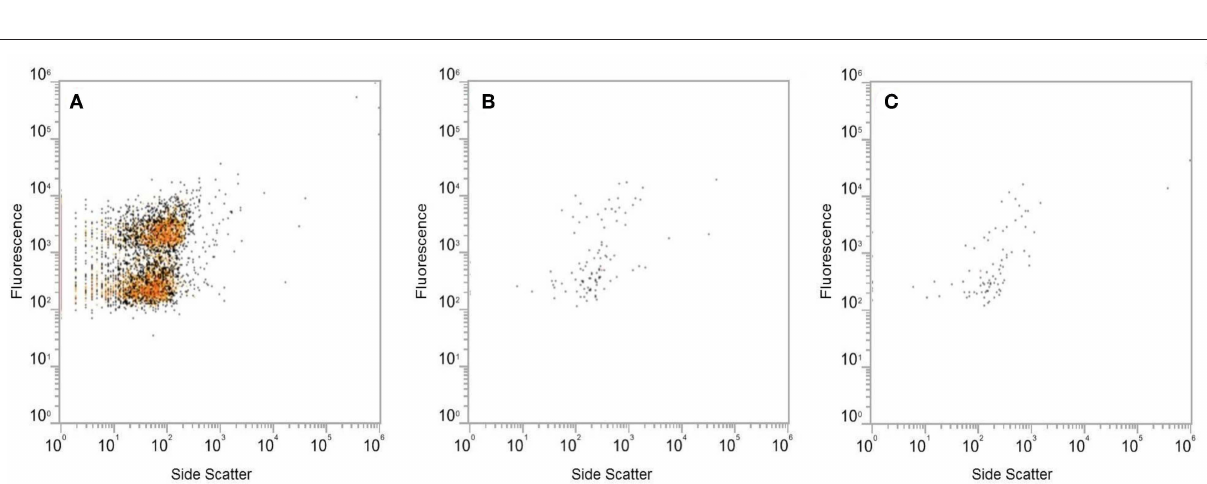
FIGURE 2 | Images of tailed phages in fecal VLP fractions identified using electron microscopy. Scale bars are indicated at bottom.